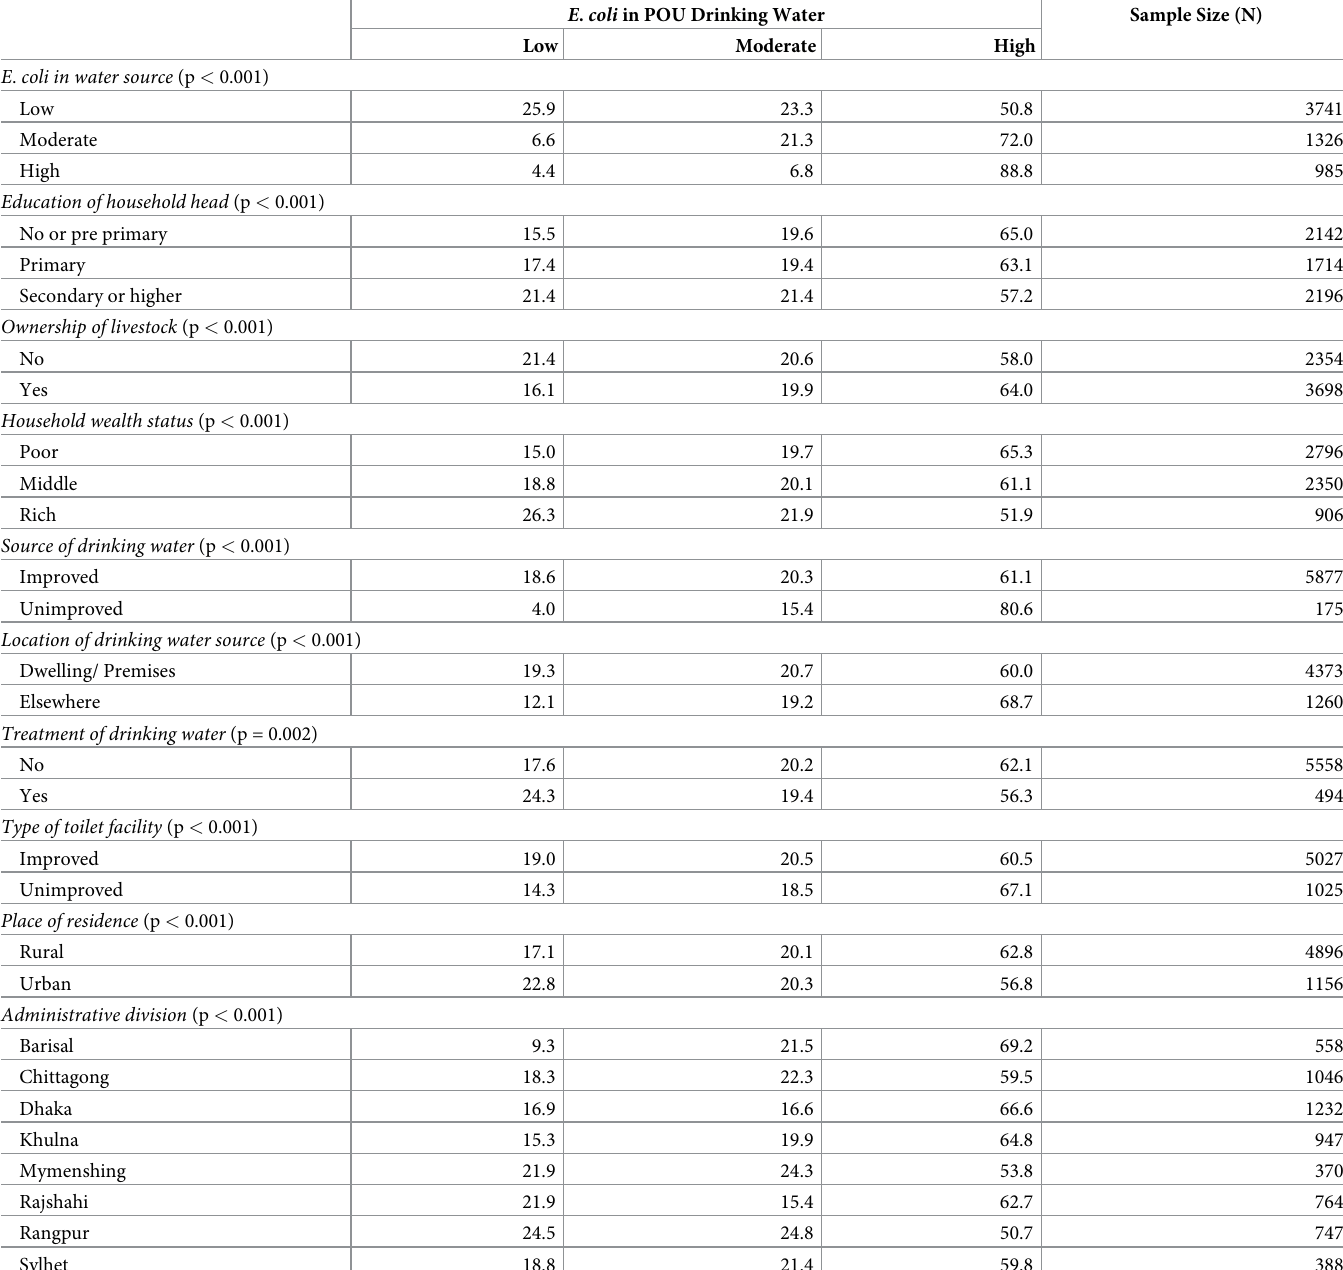
Table 1. Percentage distribution of households with various level of E . coli contaminations in drinking water at the point of use